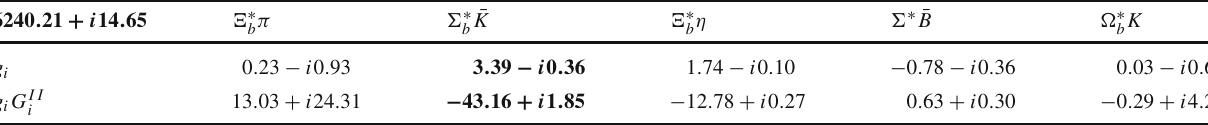
The bold number indicates the pole that can be associated with the experimental data Table 24 The coupling constants to various pseudoscalar-baryon channels and g i G II (all units are in